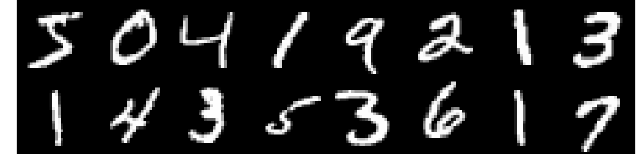
Figure 3. First 16 images of MNIST training